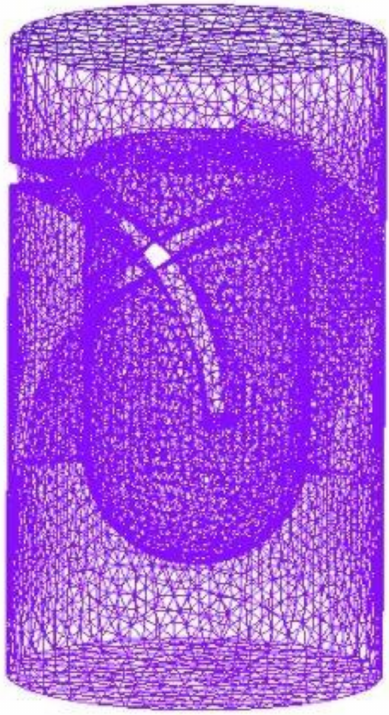
Figure 4. Mesh model of the